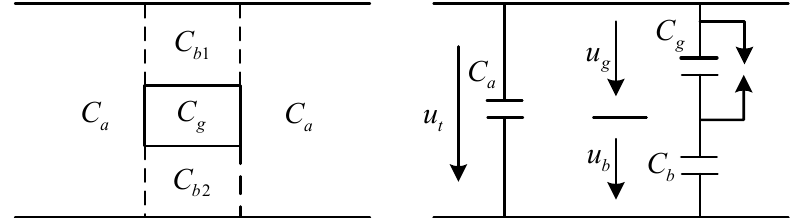
Figure 2. Three-capacitance model for PD.